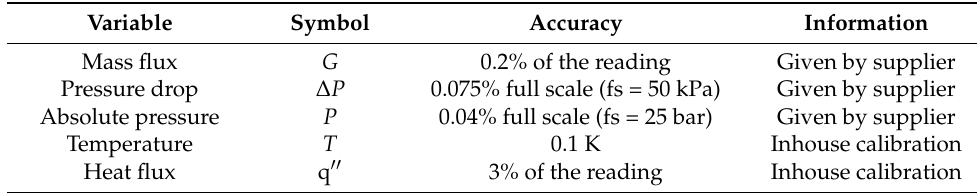
Table 2. Measurement accuracy.